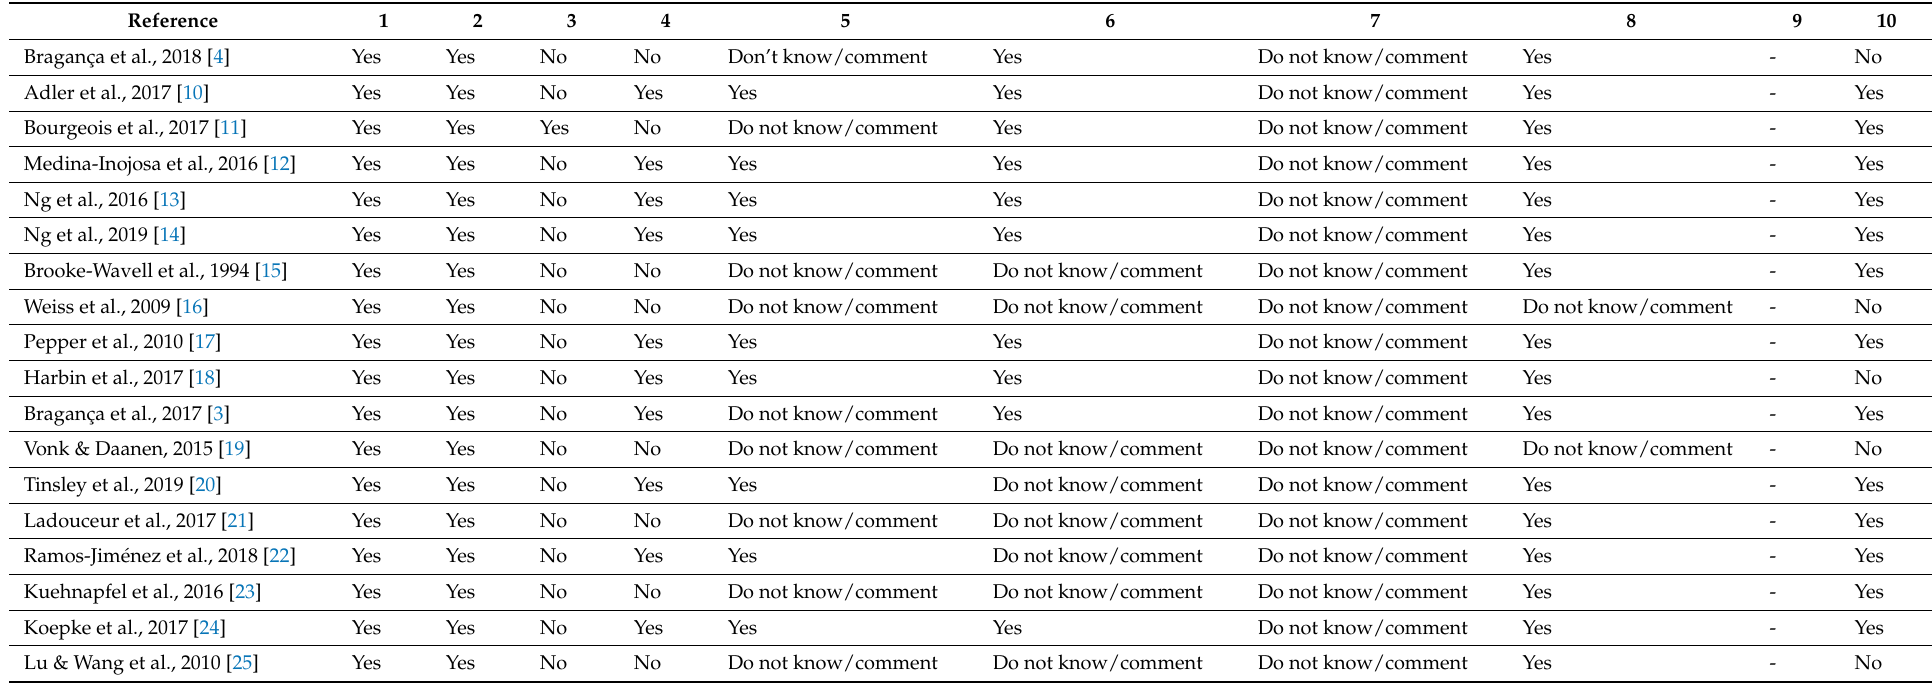
Table 2. First ten questions from the AXIS